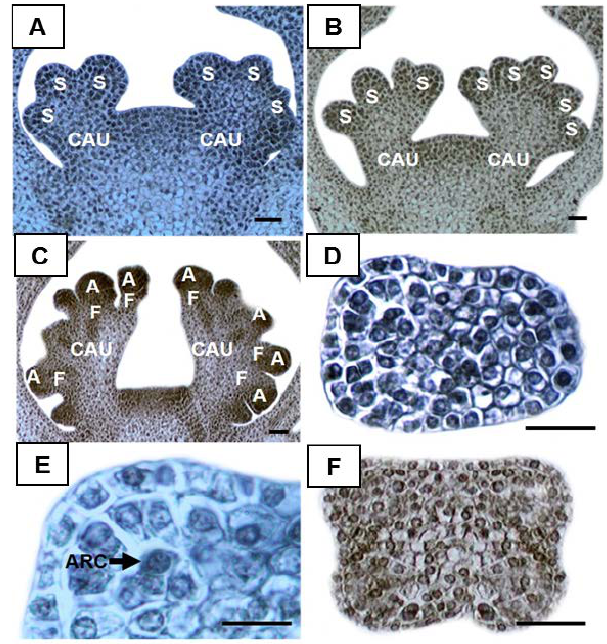
Fig. 3. Stage 3: Stamen primordia initiation (A, B) and Stage 4: Stamen differantiation into anther and filament (C, D, E, F). A. Stamen primordia differentiation on CAU. B. CAU